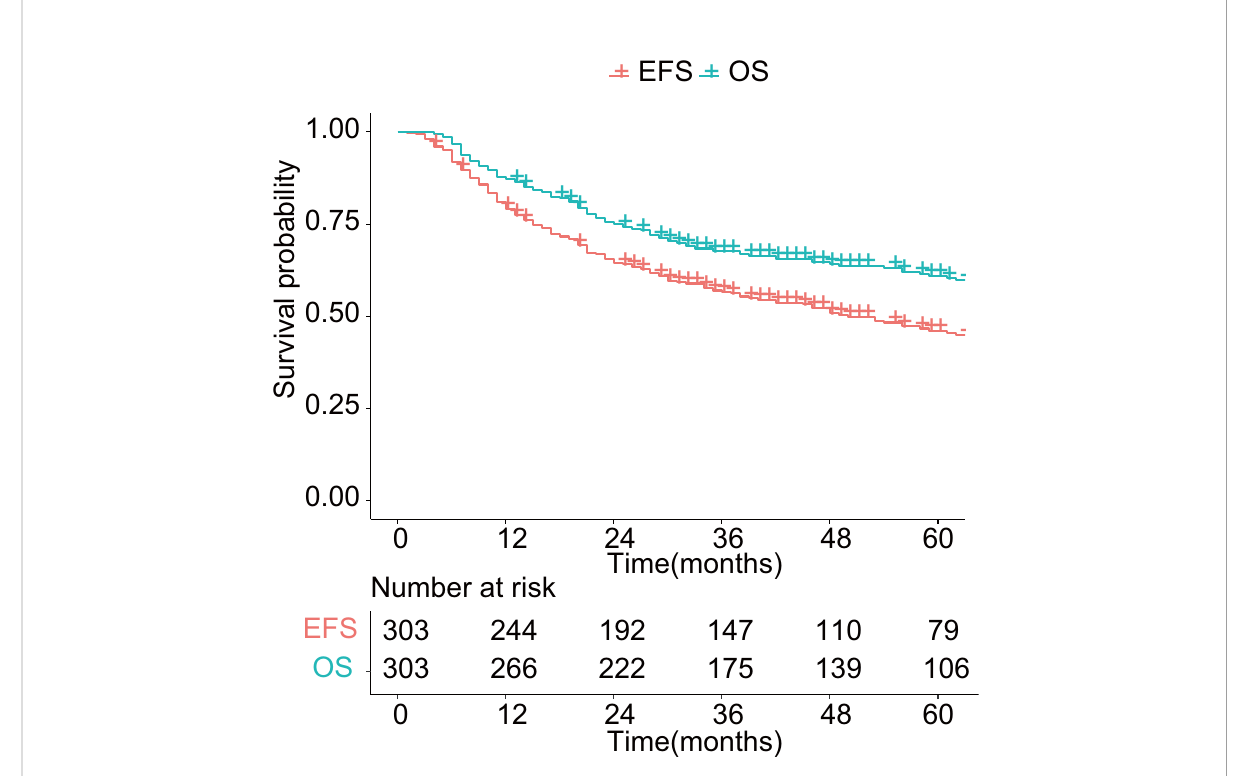
FIGURE 1 Overall survival and event-free survival in patients with sinonasal malignancies. OS: overall survival; EFS: event-free